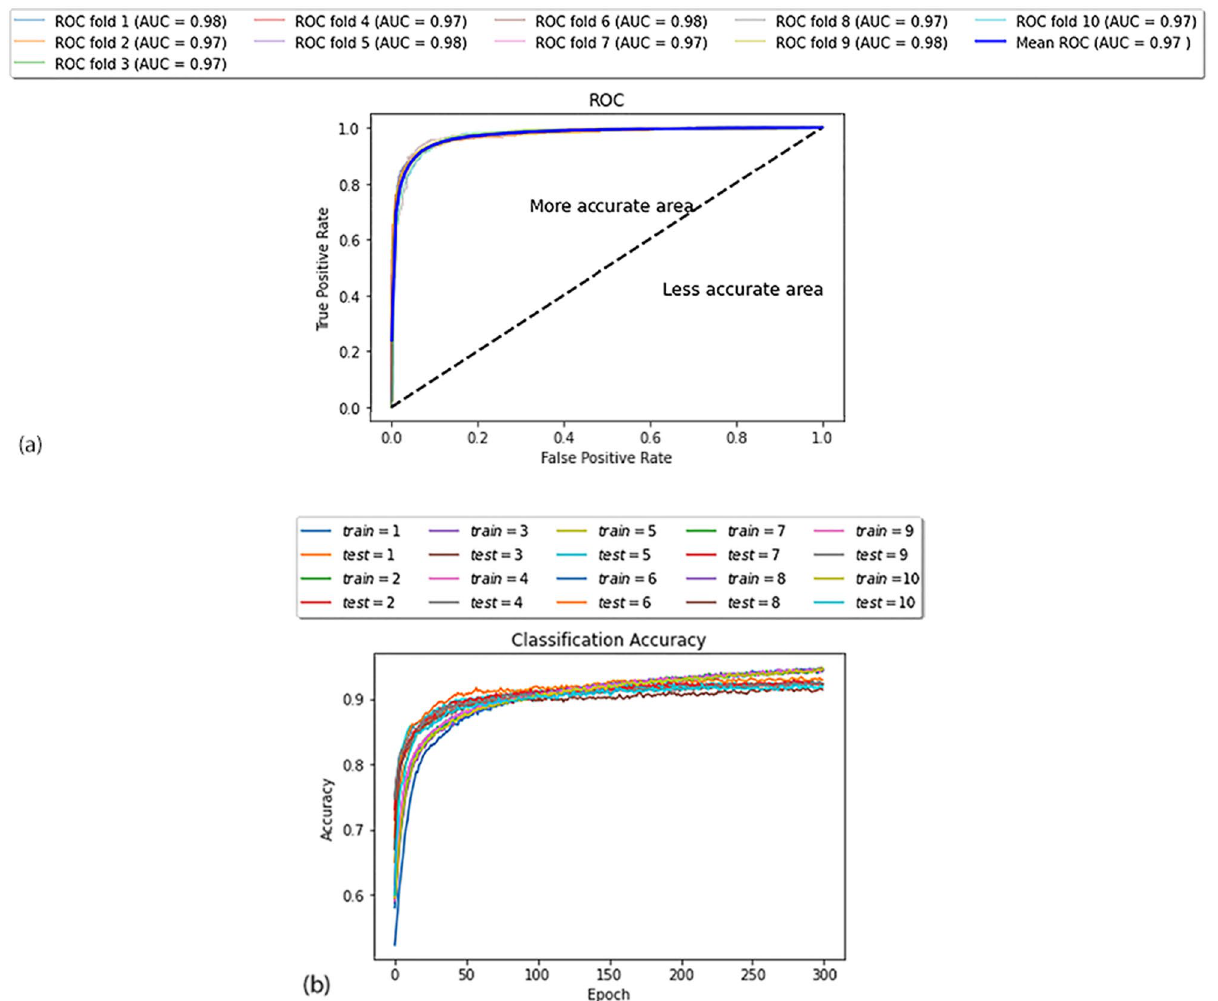
Figure 1. The ROC and accuracy diagram of tenfold-cross validation. ( a ) The ROC curves and ( b ) accuracy diagram were generated on the entire feature set.